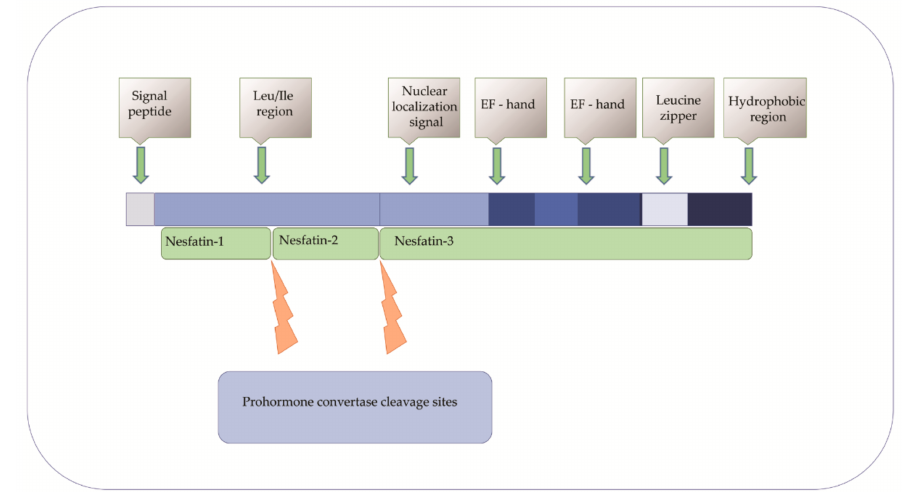
Figure 1. Structural domains of NUCB2 and its processing to protein derivatives, i.e., nesfatin-1, nesfatin-2, and